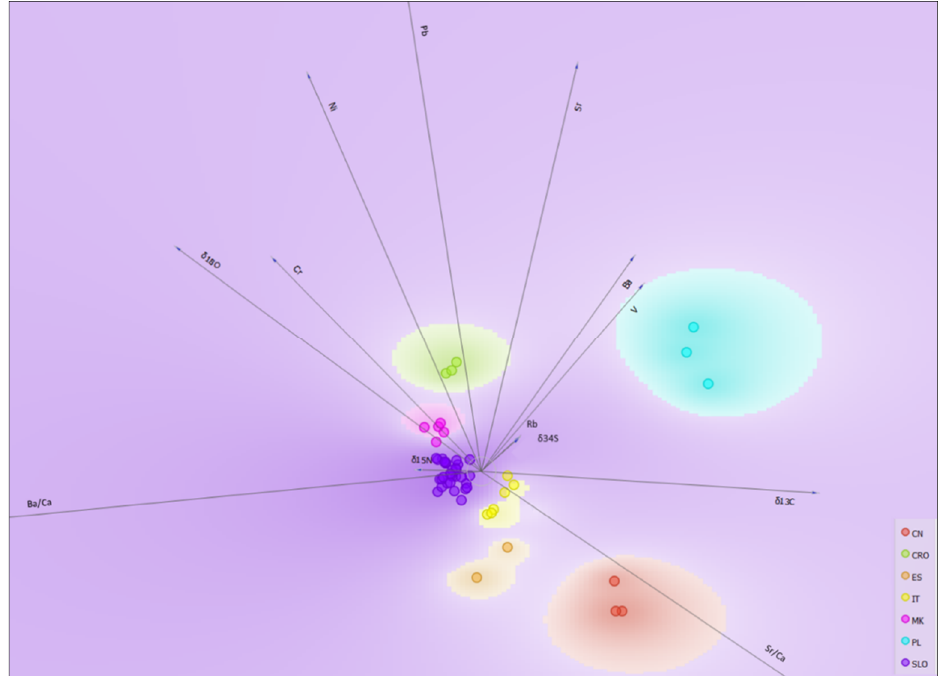
Figure 7. Projection of unit vectors for discriminant analysis (DA) of truffle samples regarding their geographical origin: CN (China), CRO (Croatia), ES (Spain), IT (Italy), MK (North Macedonia), PL (Poland), SLO (Slovenia).